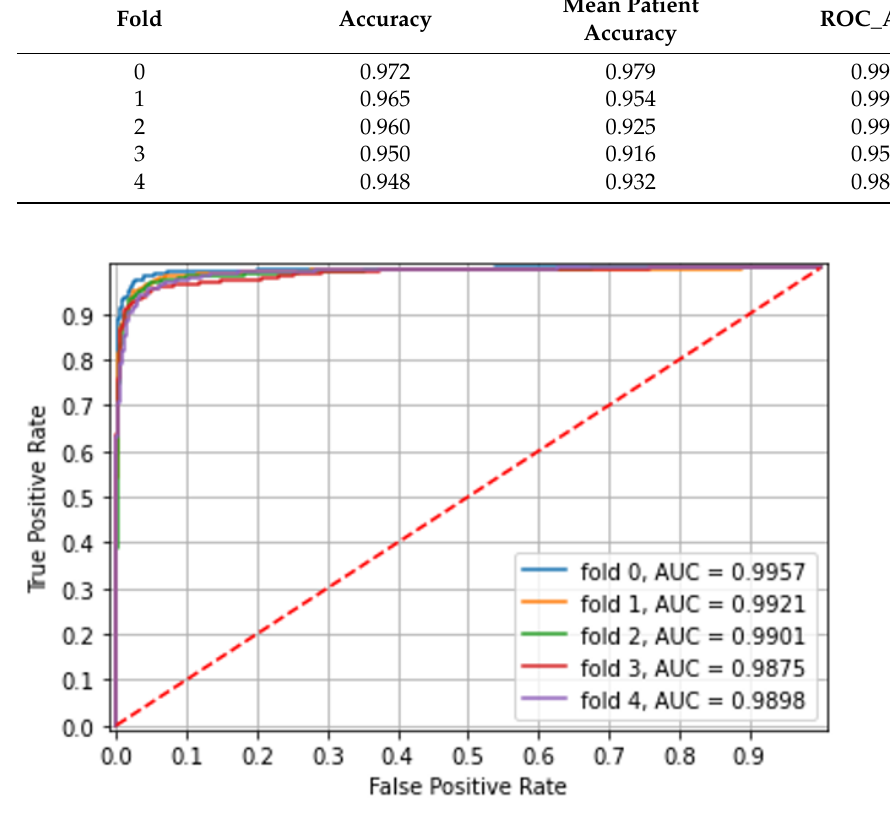
Figure 5. Experiment 5 — Grading of small bowel CE mucosal ulcerations